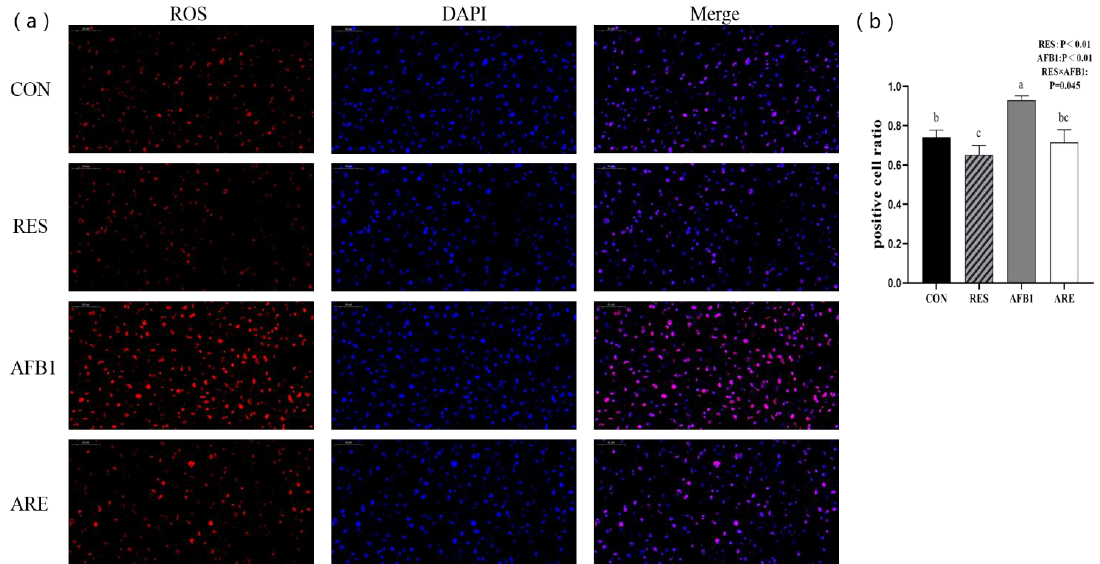
Figure 4. Analysis of ROS content in di ff erent groups (40 × magnification). ( a ) Representative pictures of ROS detection using dihydroethidium (DHE)-stained liver cryosections in mice. Scale bars, 50 µ m. ( b ) Quantification of ROS content was performed by measuring gray values using Image-Pro Plus 6.0 software. ( n = 3 per genotype). All data were analyzed by using two-way ANOVA and Duncan’s post hoc testing, where appropriate. Data are represented as mean ± SEM, n = 3. a – c Mean values within a line with di ff erent superscript letters were significantly di ff erent ( p < 0.05). Table 4. The e ff ect of dietary resveratrol supplementation on the hepatic redox status in AFB 1 -challenged